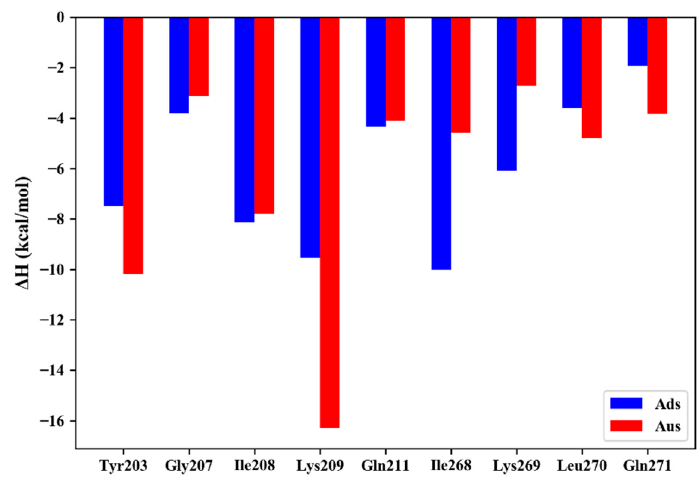
Figure 1. The key residues that contribute more than − 2.5 kcal/mol in Ads and Aus.